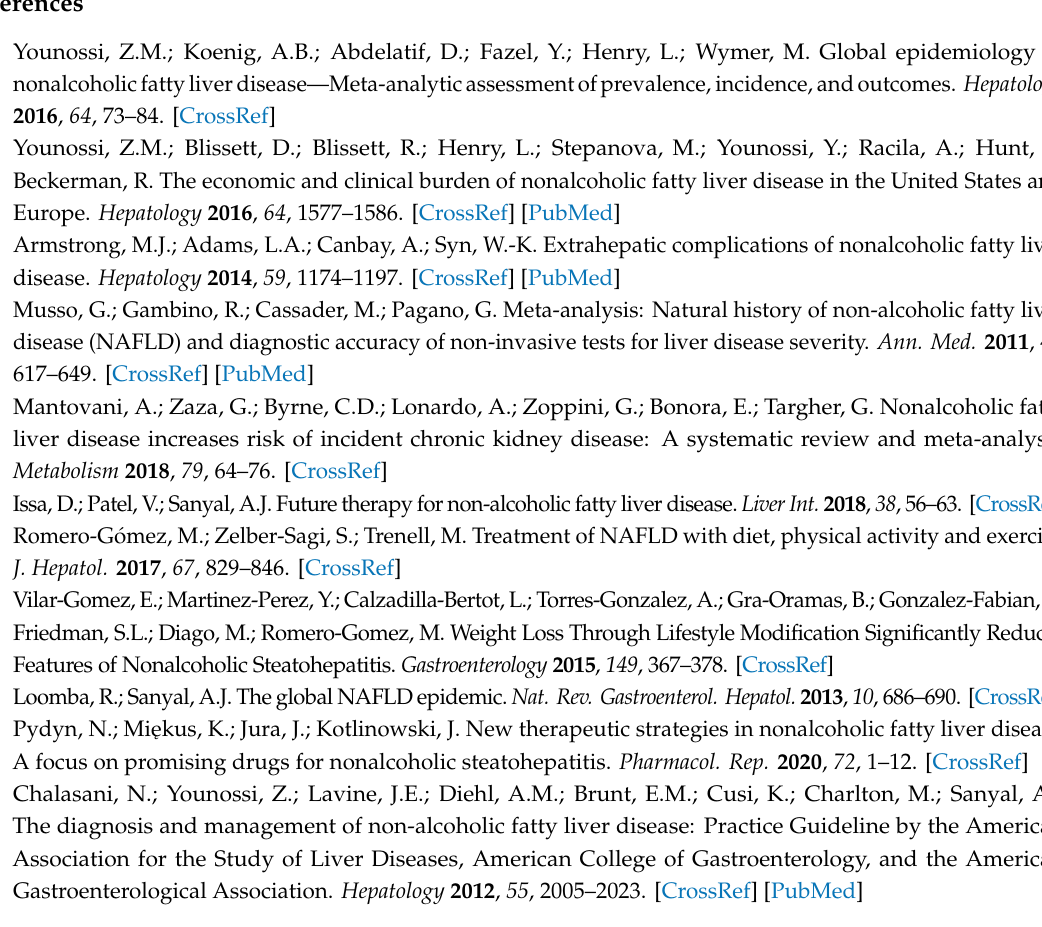
Figure S1: Flow chart of the ethyl acetate fraction of Amomum xanthioides (EFAX) acquisition. Figure S2: Chemical constitutions and quantitative analysis of EFAX using ultrahigh-performance liquid chromatography–tandem mass spectrometry (UHPLC-MS / MS) chromatograms. Table S1: Composition of normal chow diet and 60% high-fat